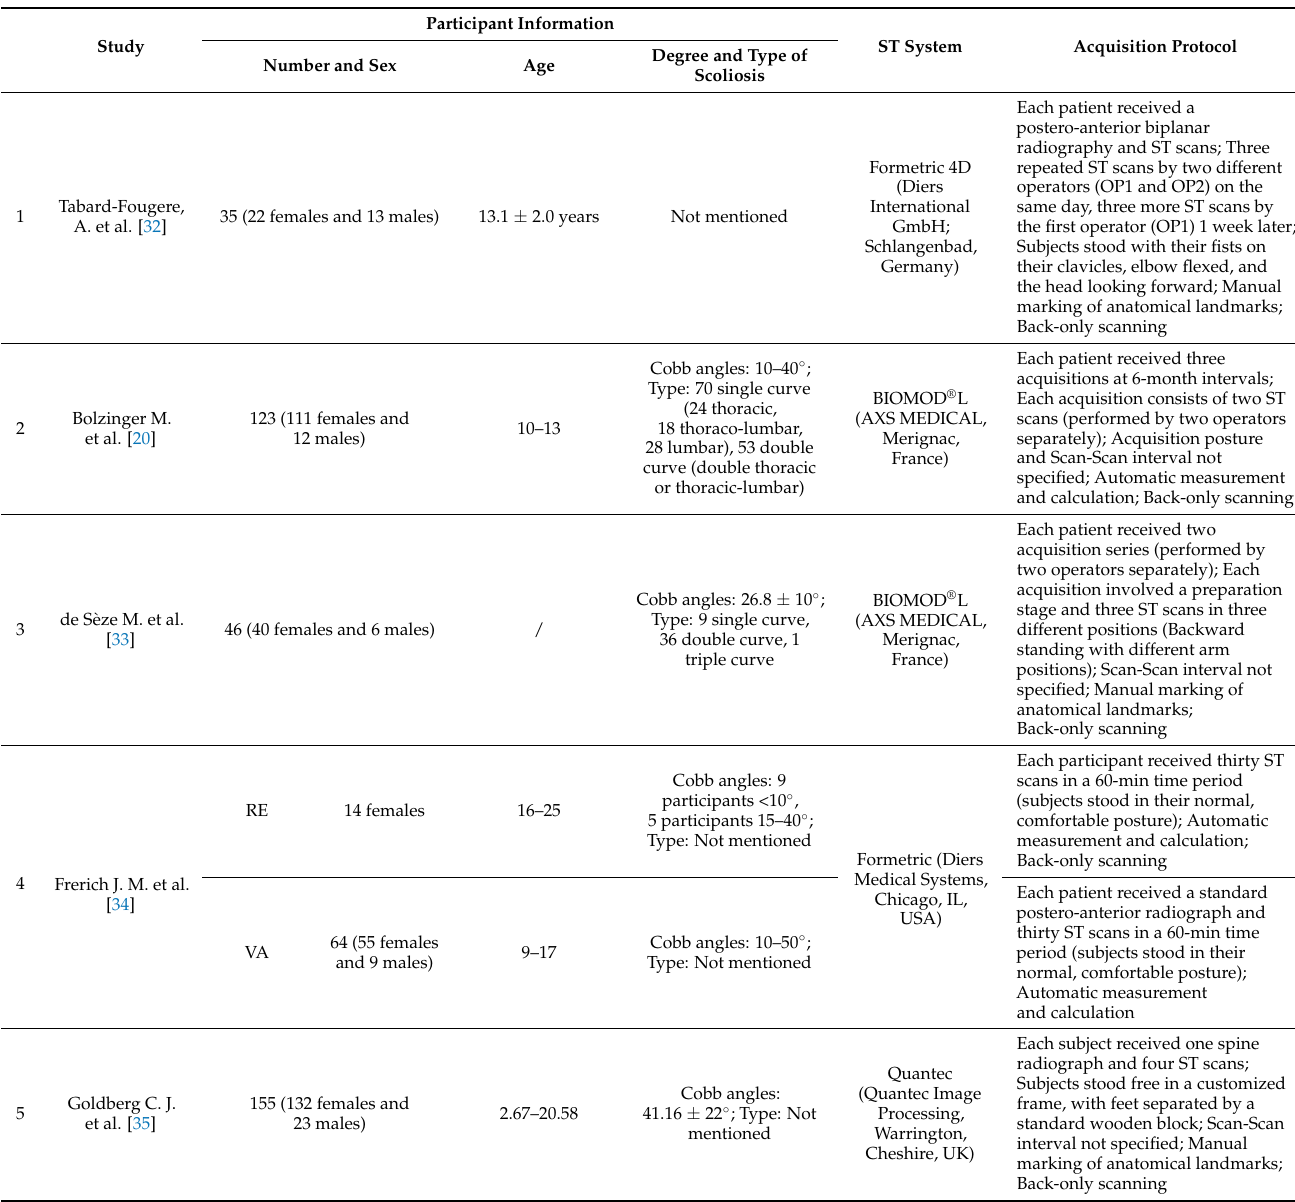
Table 5. Characteristics of the